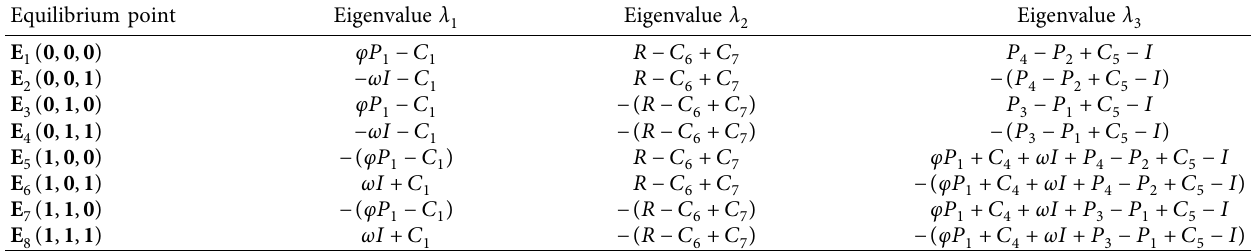
Table 4: Eigenvalues of Jacobian matrix.